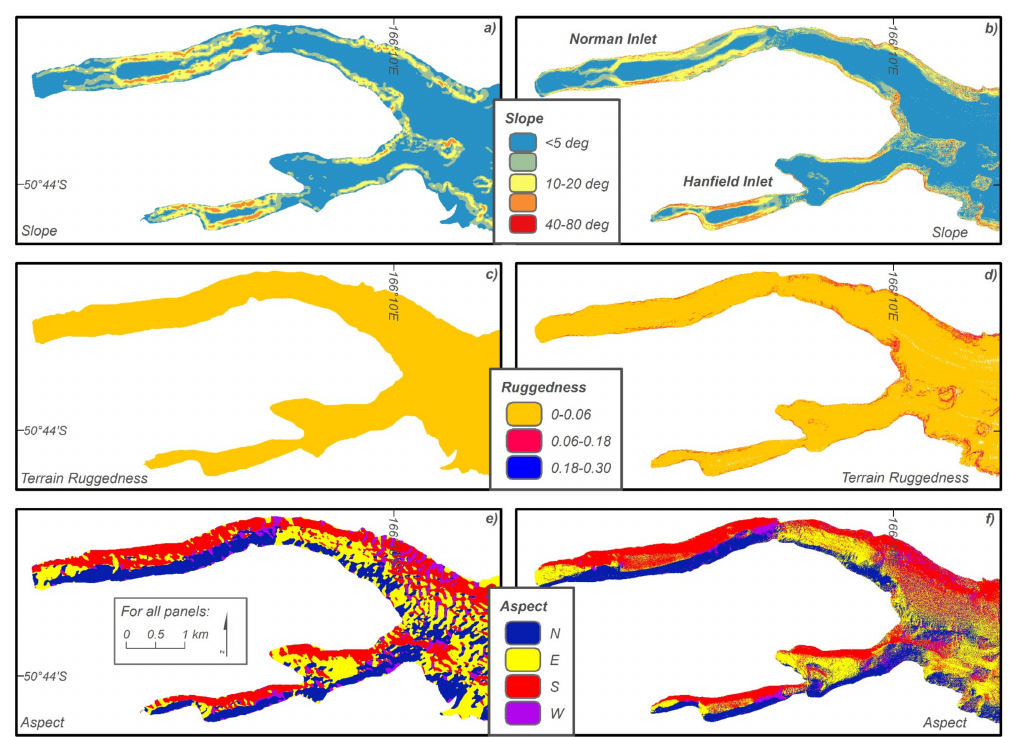
Figure 5. Bathymetric surface outputs for the Norman and Hanfield Inlet study area created using Benthic Terrain Modeler (BTM) v.3.0 in ArcMap 10.3.1 [37]: ( a ) Pre-2015 slope; ( b ) post-2015 slope; ( c) pre-2015 terrain ruggedness; ( d ) post-2015 terrain ruggedness; ( e ) pre-2015